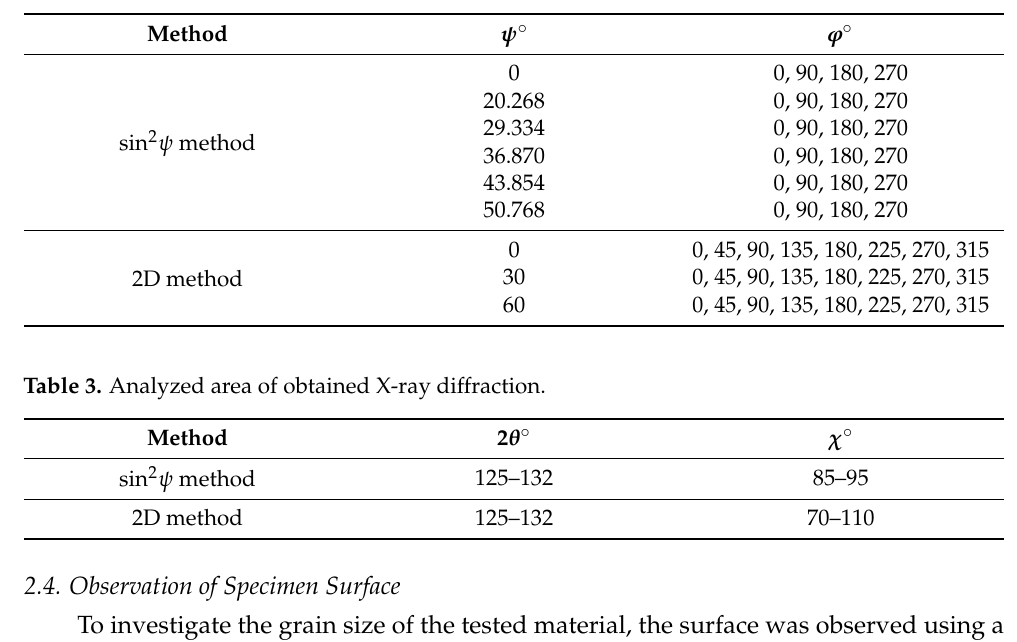
Figure 5. Schematic diagram and coordinates of XRD system with 2D-PSPC. ( a ) Coordinates of the system; ( b ) coordinates on the 2D-PSPC. Table 2. Measuring conditions for each method.